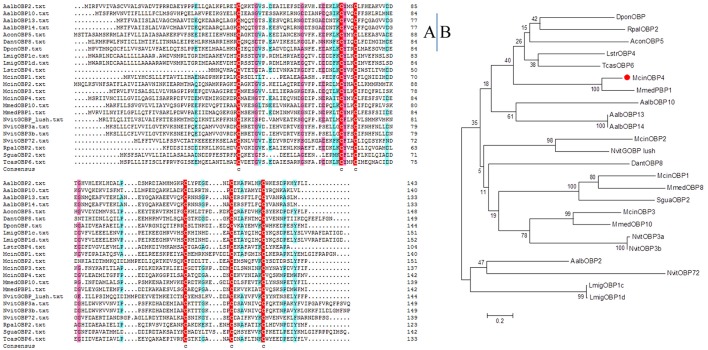
Sequence alignments and Phylogenetic analysis of McinOBP4. (A) Alignment of McinOBP4 from hymenopteran insects as well as other insects. (B) Neighbor-joining phylogenetic tree was constructed used MEGA 6.0 with a p-distance model and a pairwise deletion of gaps.